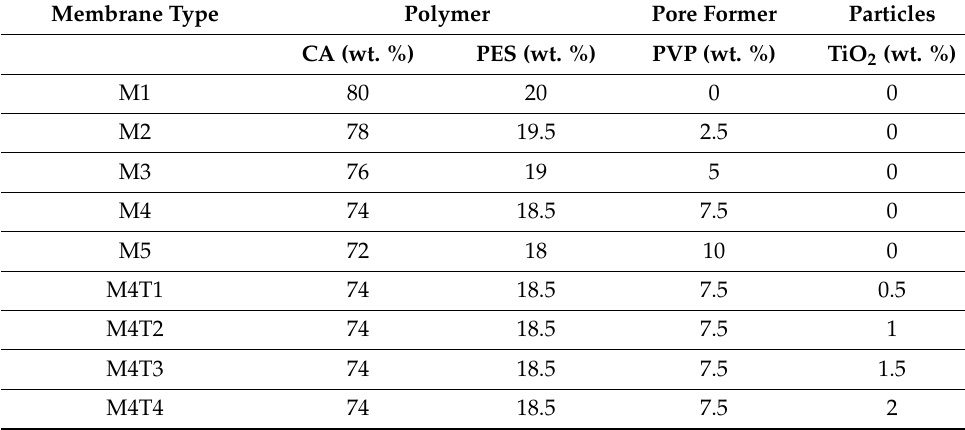
Figure 1. Preparation method of the mixed-matrix nanocomposite membranes. Table 1. Composition of the prepared